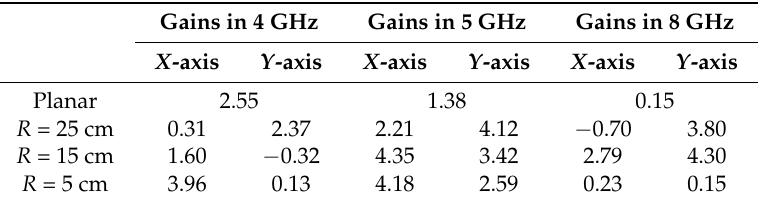
Table 4. The gains of the proposed antenna at 4, 5, and 8 GHz under bending along the X-axis and the Y-axis.